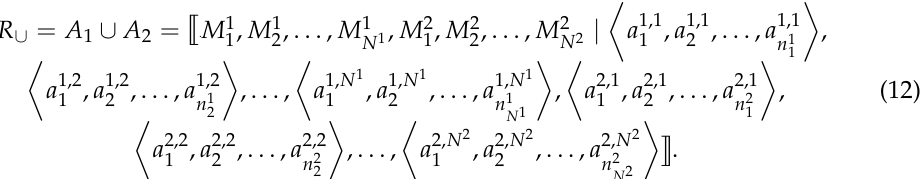
Figure 1. An example of two compatible aggregates. Figure 2. An example of two quasi-compatible aggregates. Figure 4. An example of two hiddenly compatible aggregates.